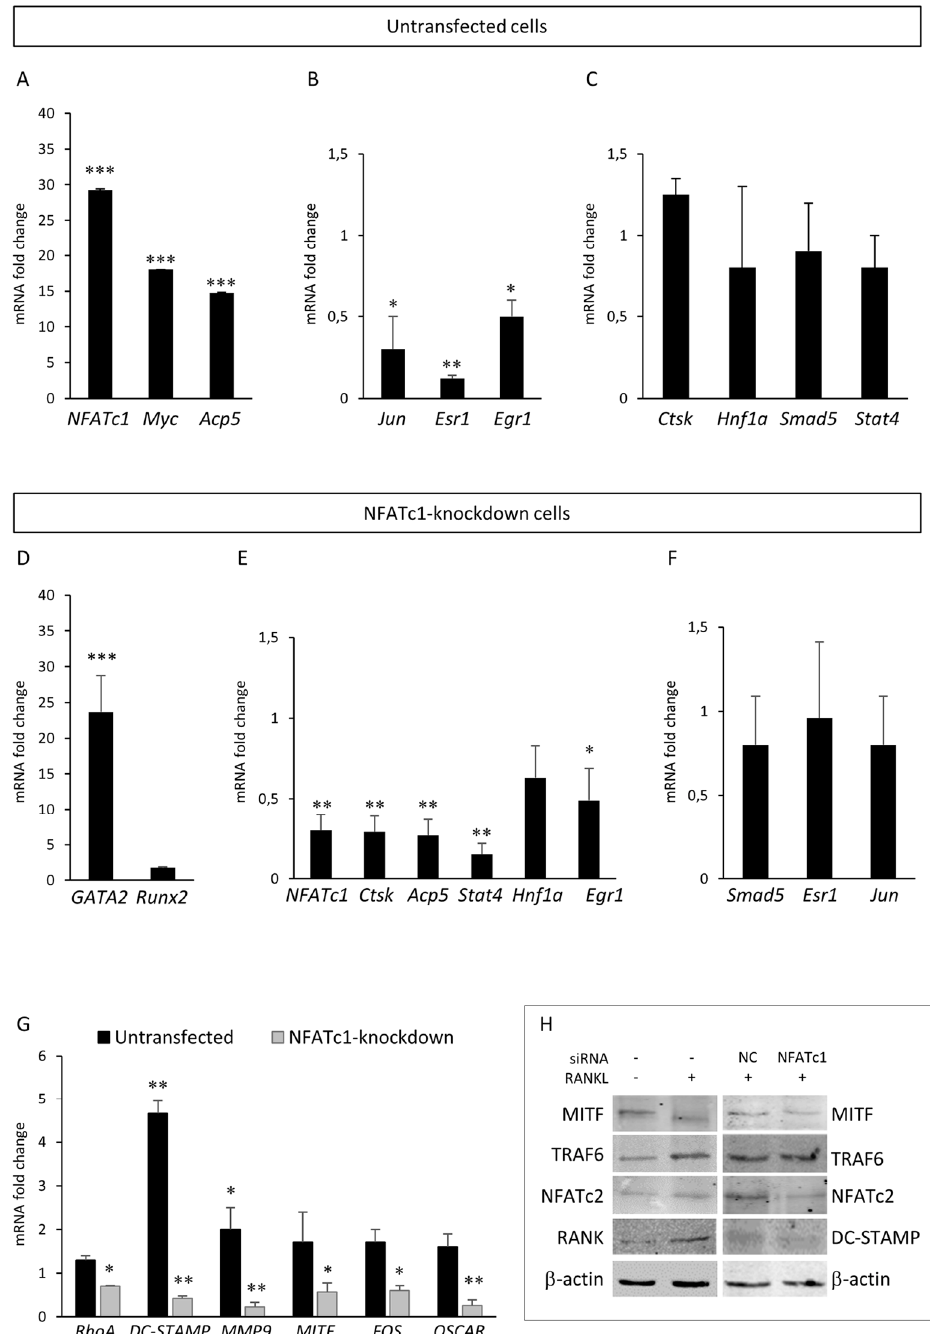
Figure 5. Effects of NFATc1 induction or depletion on different genes involved in the RANK–RANKL pathway. Cells were untransfected and RANKL-induced. QPCR results of ( A ) NFATc1, Myc and Acp5 ; ( B ) Jun, Esr1 and Egr 1; and ( C ) CtsK, Hnf1a, Smad5 and Stat4 . Cells were NFATc1-knockdown and RANKL-induced. QPCR results of ( D ) GATA2 and Runx2 ; ( E ) NFATc1, CtsK, Acp5, Stat4, Hnf1a and Egr1 ; ( F ) Smad5, Esr1 and Jun ; and ( G ) RhoA, DC-STAMP, MMP9, MITF, FOS and OSCAR . The mRNA expression levels were presented as relative values to those expressed in siRNA-NC transfected or untransfected cells arbitrarily set at 1.0. The results shown are the means ± SD of three experiments (each of which was performed in triplicate). * p < 0.05, ** p < 0.01 and *** p < 0.001 versus the control. ( H ) Western blot results of MITF, TRAF6, NFATc2, DC-STAMP and RANK proteins in untransfected and NFATc1-knockdown cells, RANKL-induced. The data shown represents two independent experiments with comparable